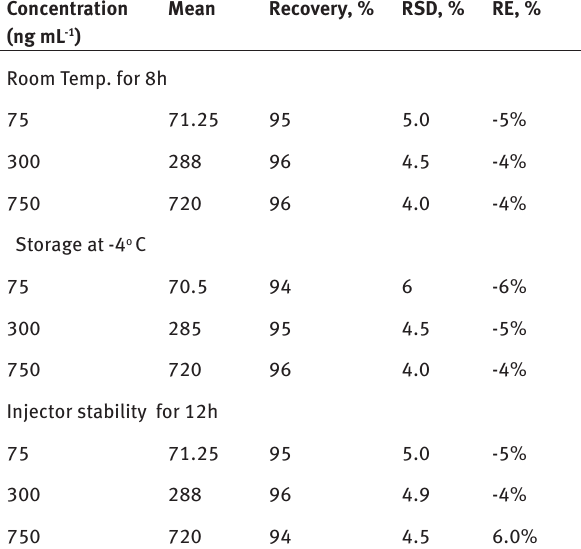
Table 5 : Stability of lixivaptan in mouse plasma based on the proposed HPLC method.